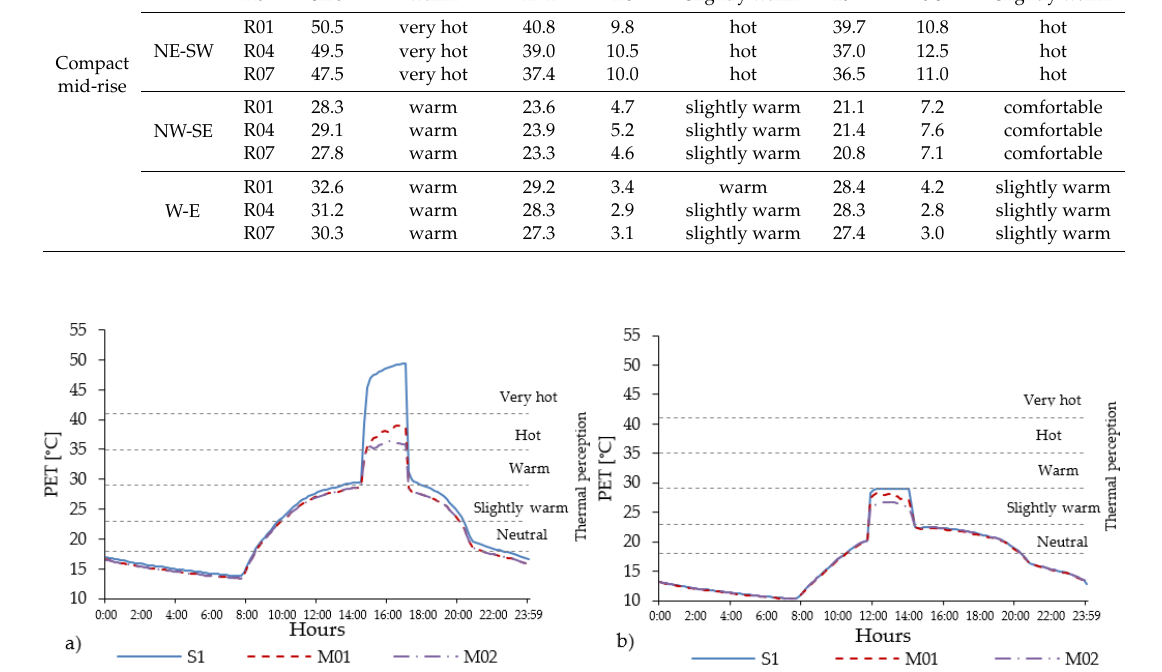
Figure 14. Daily evolution of the PET level in compact mid-rise urban area for scenarios S1, M01 and M02 registered in R04, located in the middle of the urban canyon for the worst orientation NE-SW ( a ) and the best orientation NW-SE ( b ).